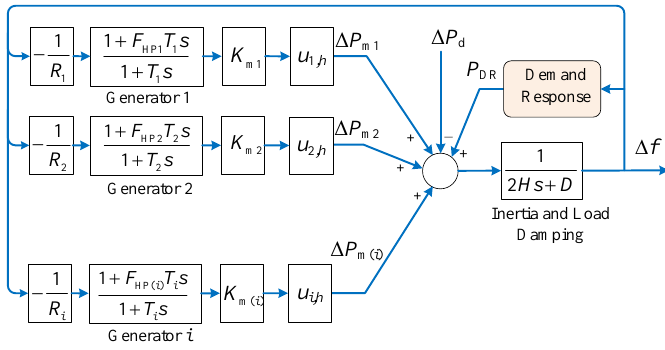
Figure 3. Frequency response model of multi generators considering DR.